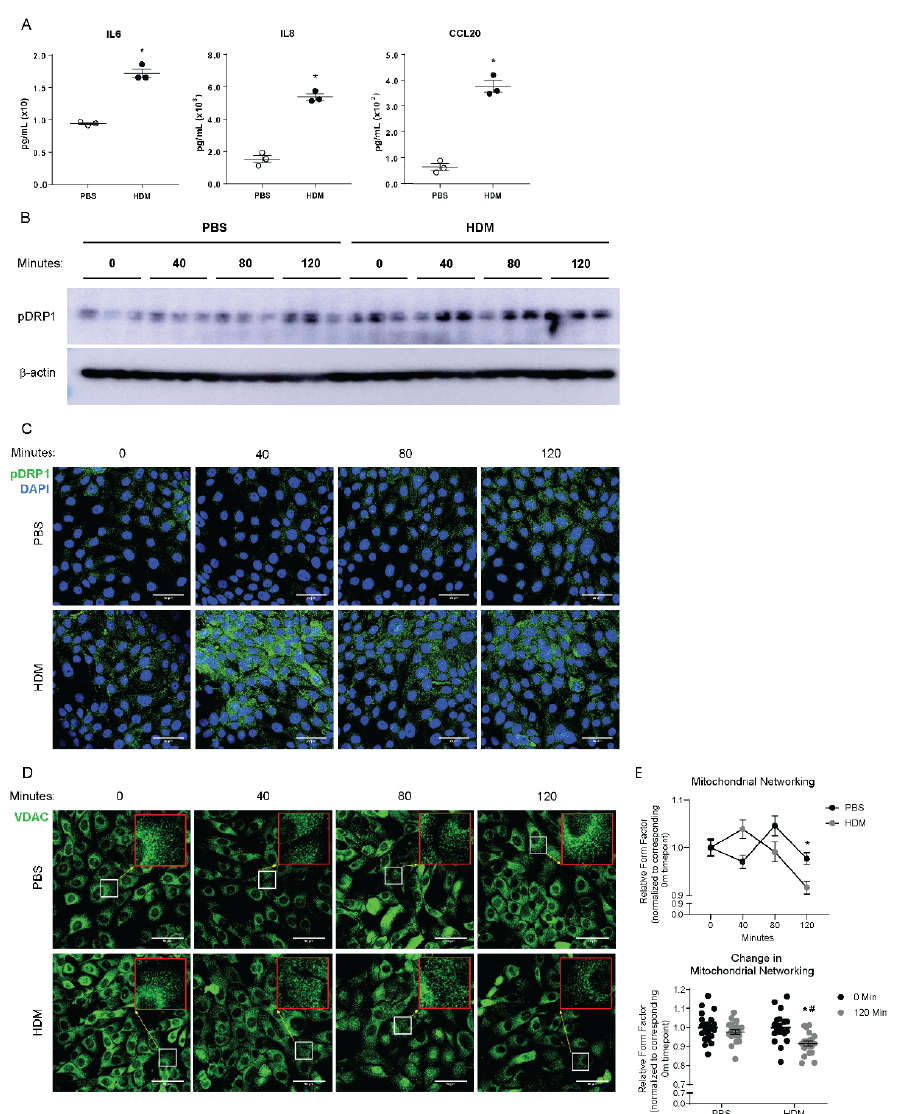
Figure 1. HDM induces mitochondrial fission in human bronchial epithelial cells. ( A ) ELISAs on supernatants from cultured HBECs, n = 3 per group; ( B ) Western blot analysis of pDRP1 in whole cell lysates, n = 3 per group; ( C ) Representative images of immunofluorescence of pDRP1 in fixed HBECs; ( D ) Representative images from immunofluorescence of VDAC in fixed HBECs with insets at 3 × magnification in red; ( E ) Quantification of mitochondrial networking based on VDAC mitochondrial immunofluorescence, form factor calculation with n = 19 images per group at 60 × magnification; ( A , B , E ) * p < 0.05 vs. PBS group, ( C ) * p < 0.05 vs. corresponding 0 Min group, # p < 0.05 vs. PBS 120 Min group. Error bars represent mean ± SEM. ( C , D ) Scale bars are 50 µ m. HDM is a complex allergen that includes components of bacterial, fungal, and HDM origins. One of the components of bacterial origin is lipopolysaccharide (LPS). LPS is known